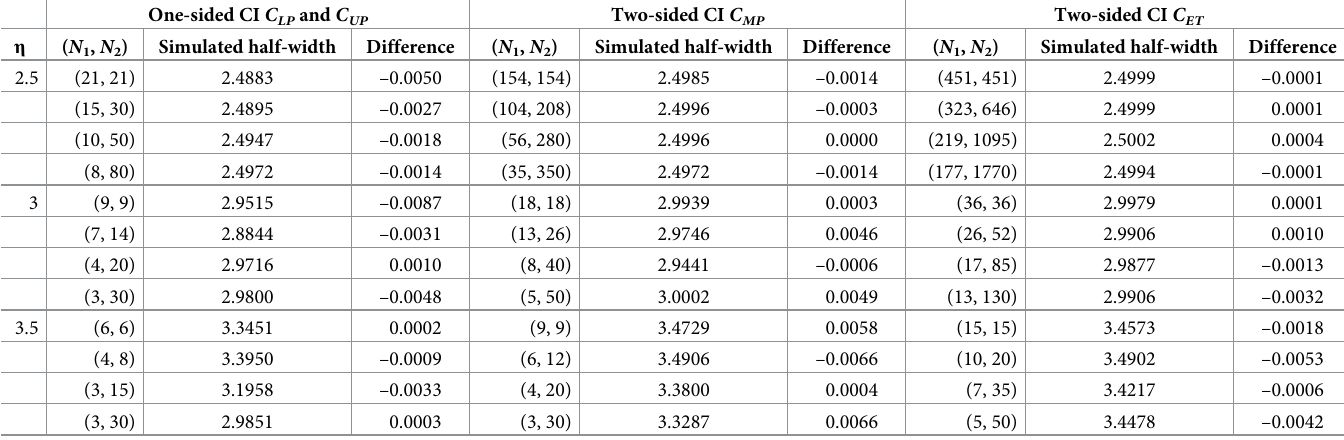
Table 3. The computed sample size, simulated half-width and errors for the 95% reference intervals of the distribution proportion 0.90. One-sided CI C LP and C UP Two-sided CI C MP Two-sided CI C